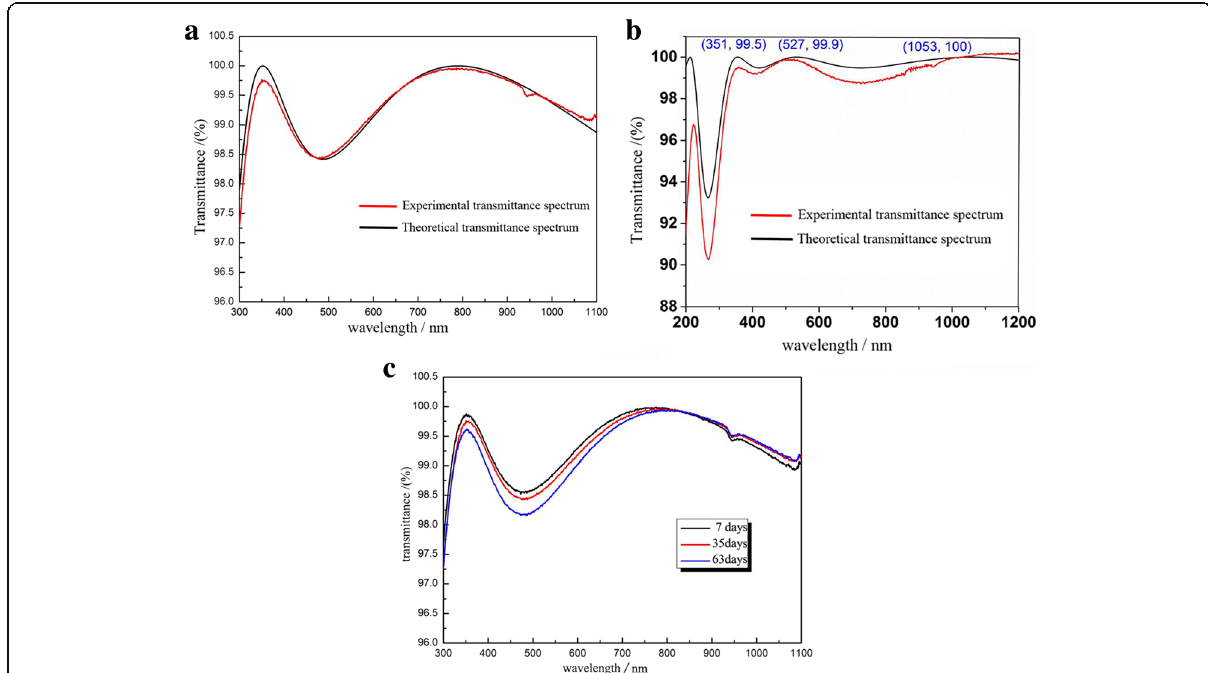
Fig. 7 a Transmittance spectrum of dual-layer AR film on fused silica substrate. b Transmittance spectrum of tri-layer AR film on fused silica substrate. c Transmittances of the dual-layer AR films after 7, 35, and 63